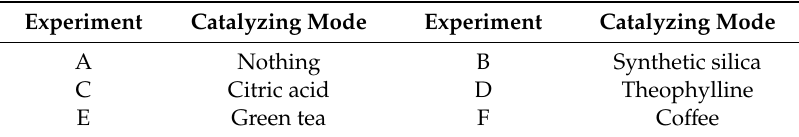
Table 1. Experimental design